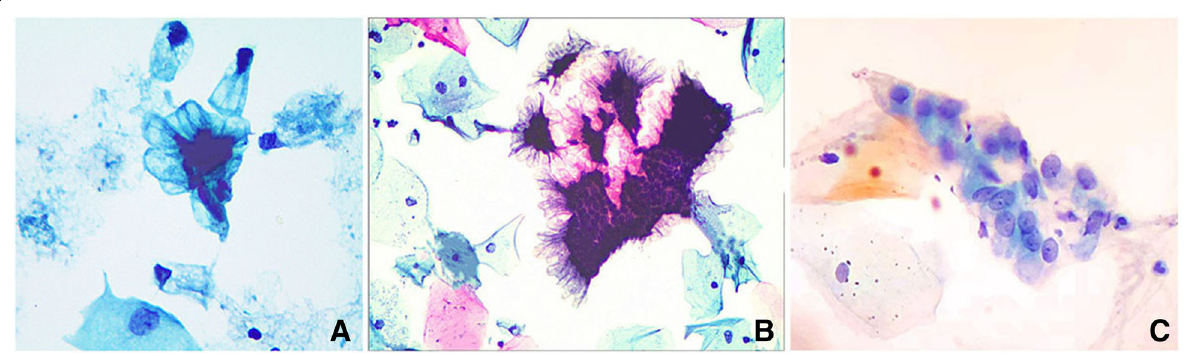
Fig. 1 The cytological features of gastric-type adenocarcinoma (GAS). a GAS cells display monolayer or honeycomb sheet. The columnar or polygonal tumor cells show pale, foamy, and vacuolated cytoplasm with well-defined cytoplasmic borders. b An abundant lacy is present at the periphery of these sheets and the polarity is lost within clusters. c The tumor cells are round to oval in shape. Occasional nucleoli can be seen (Papanicolaou staining,